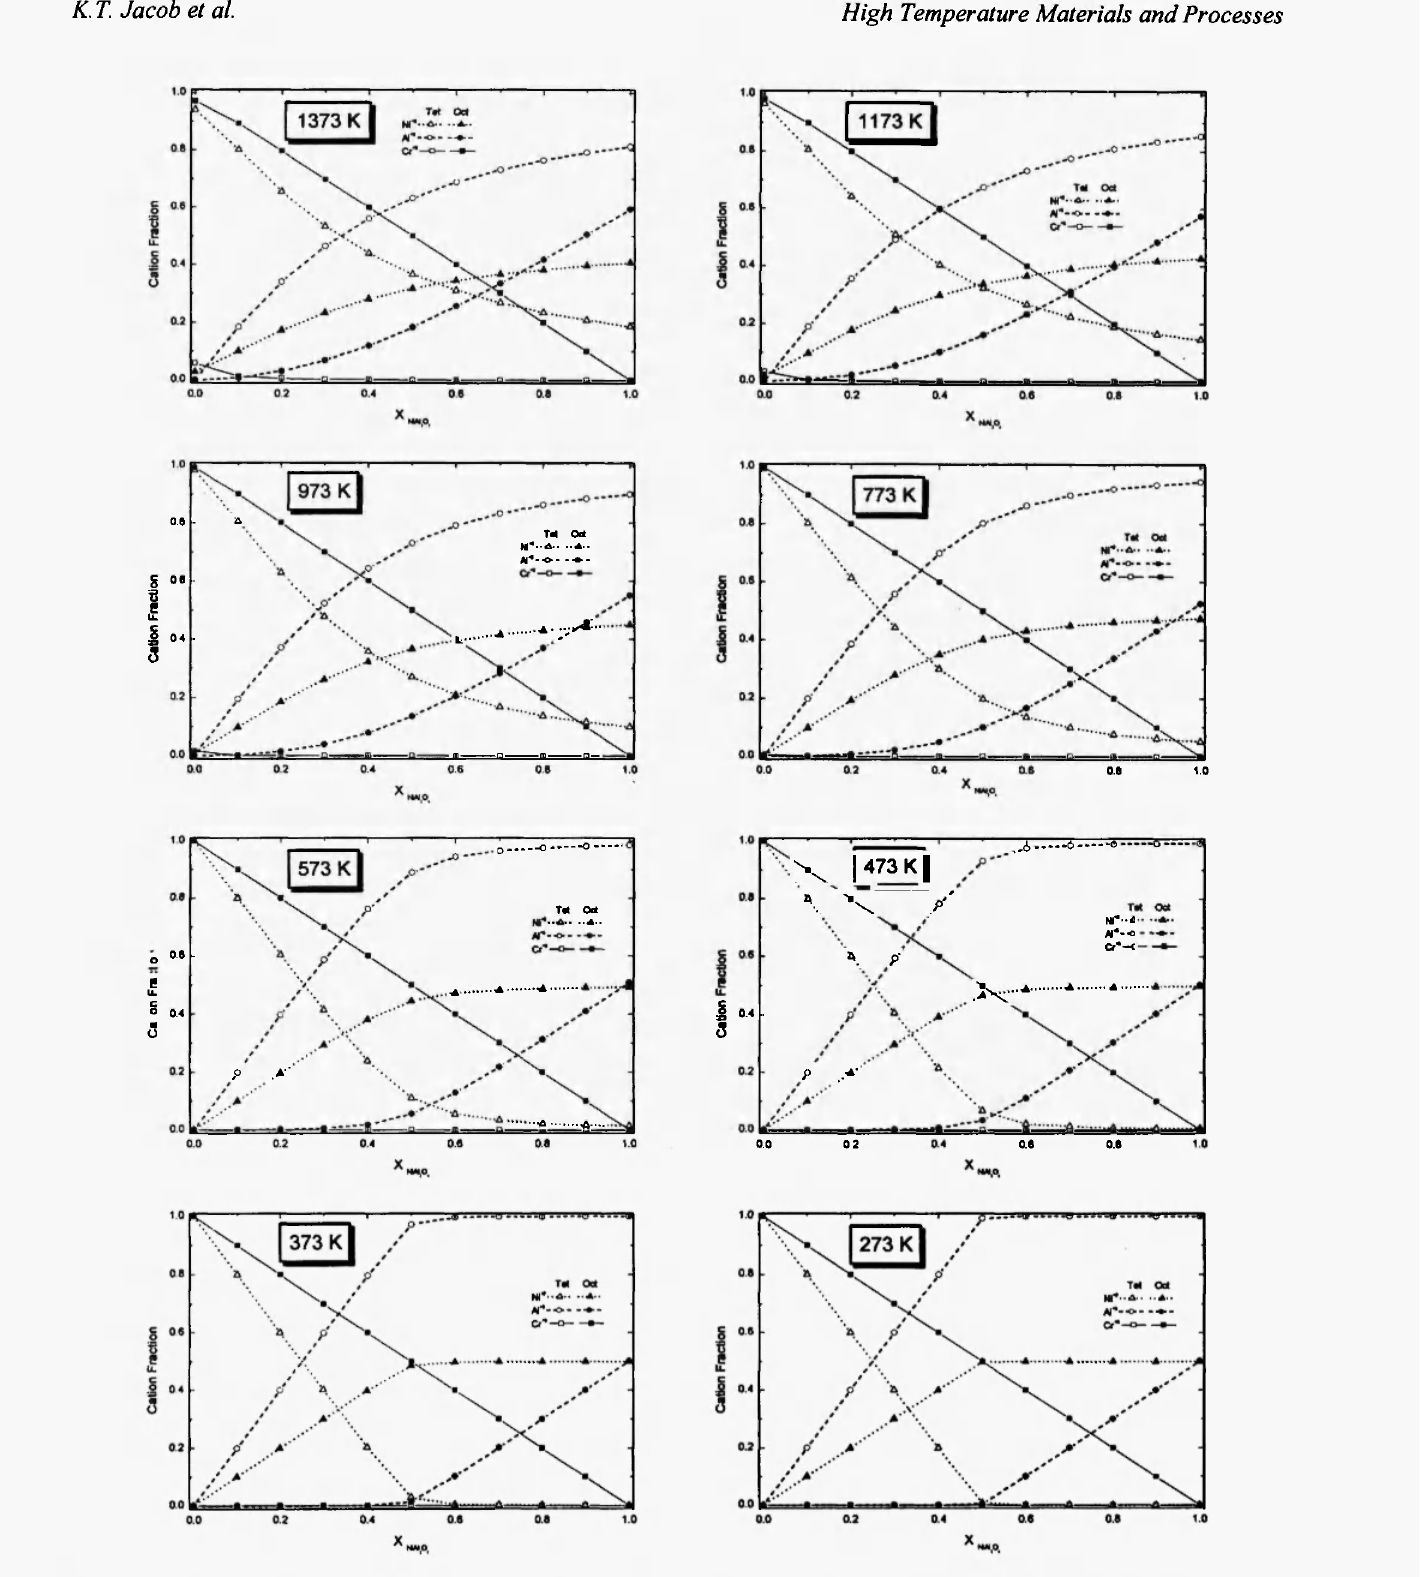
Fig. 7: Variation of cation distribution in spinel solid solution according to model of Jacob et al. at different